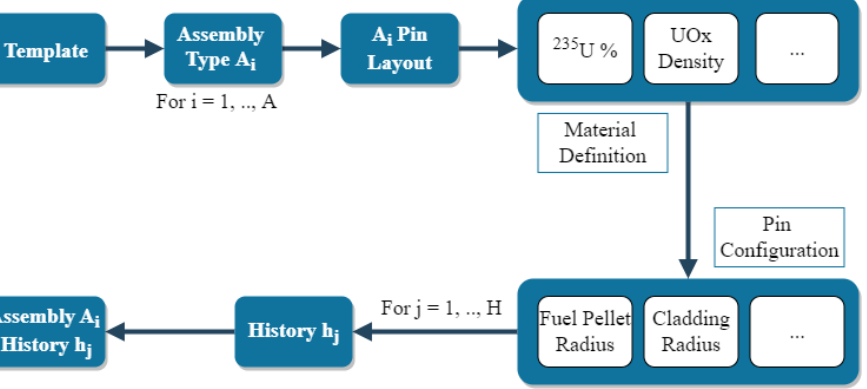
Figure 1. Construction of the Polaris inputs from